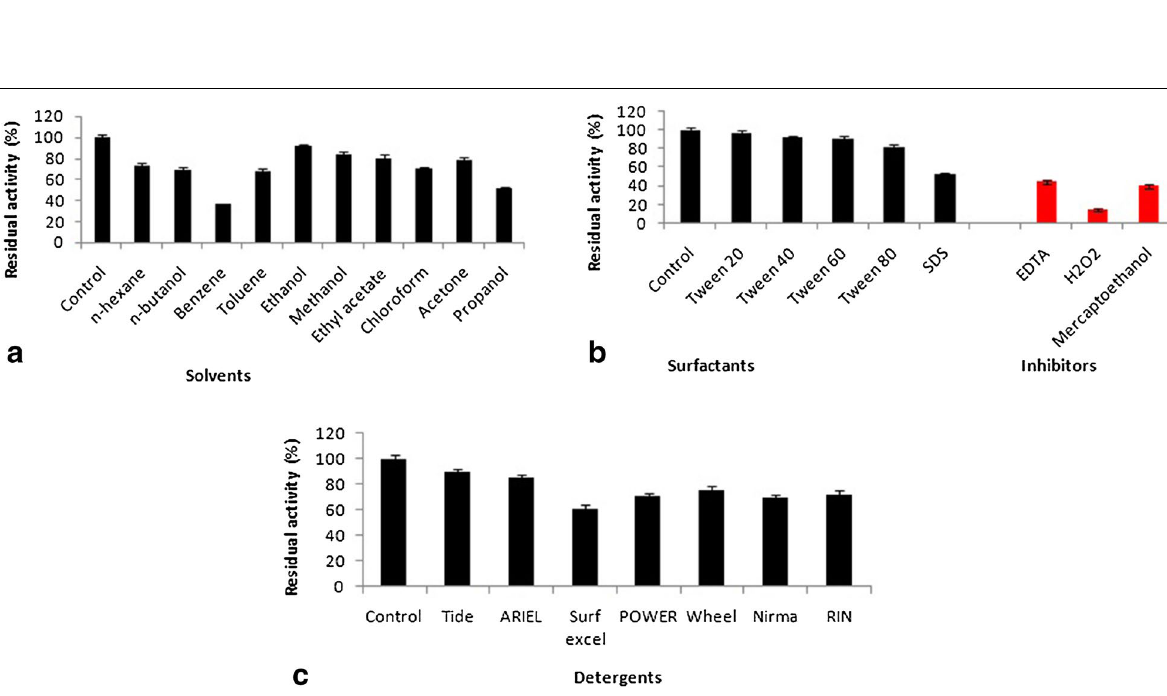
Fig. 5 Effect of various a organic solvents, b surfactants and inhibitors, and c commercially available detergents on the stability of amylases. Values represent mean ±